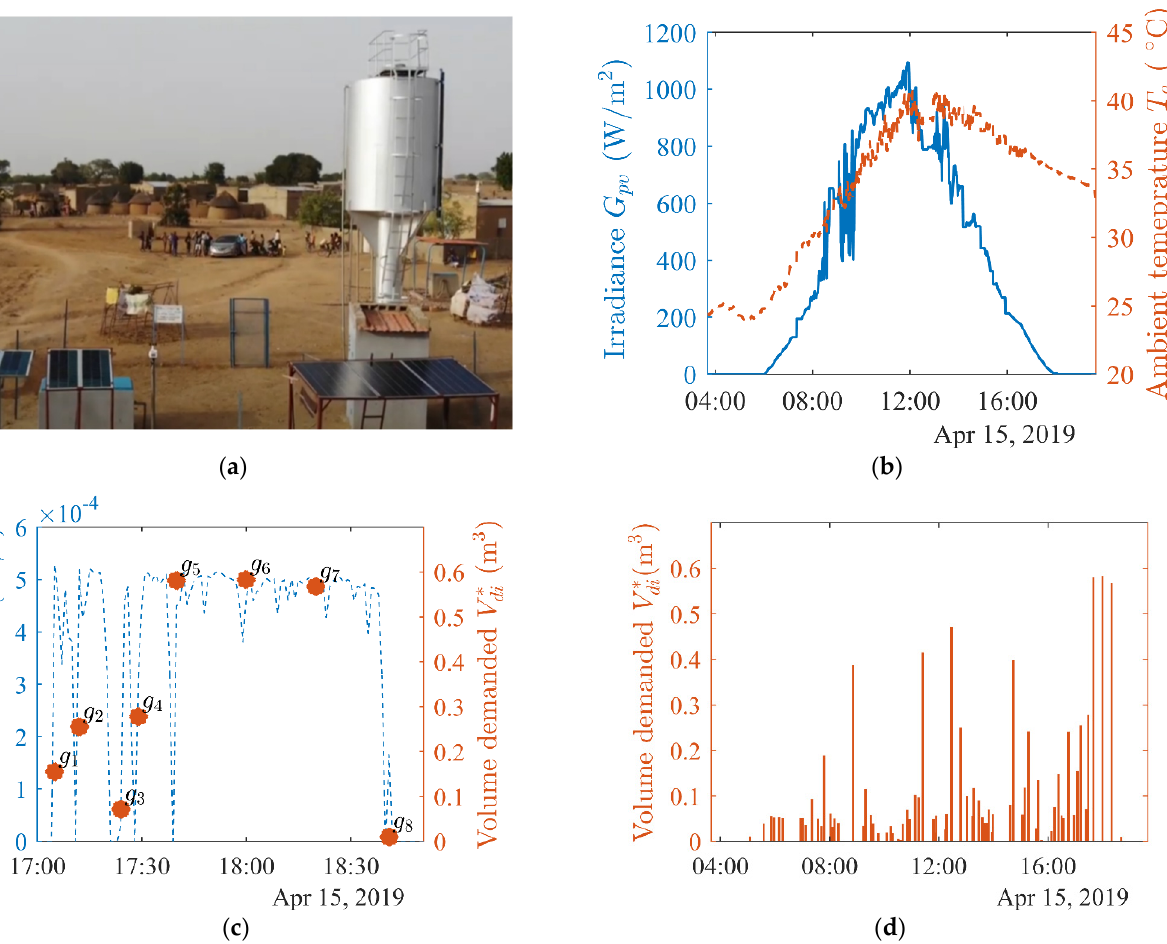
Figure 3. ( a ) Overview of the PVWPS of Gogma. ( b ) Measured irradiance on the plane of the PV modules G pv and ambient temperature T a (model inputs). ( c ) Measured collected flow rate. ( d ) Group of users g i (model Table 1. Technical parameters for Gogma.